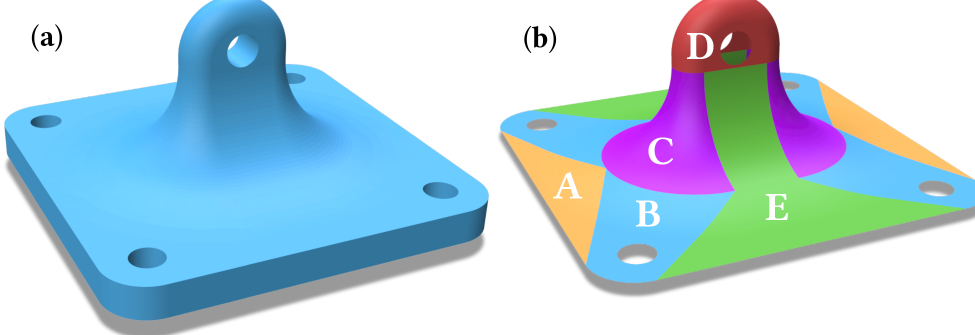
Figure 5. ( a ) Part for evaluation ( b ) Partitioning of surfaces.